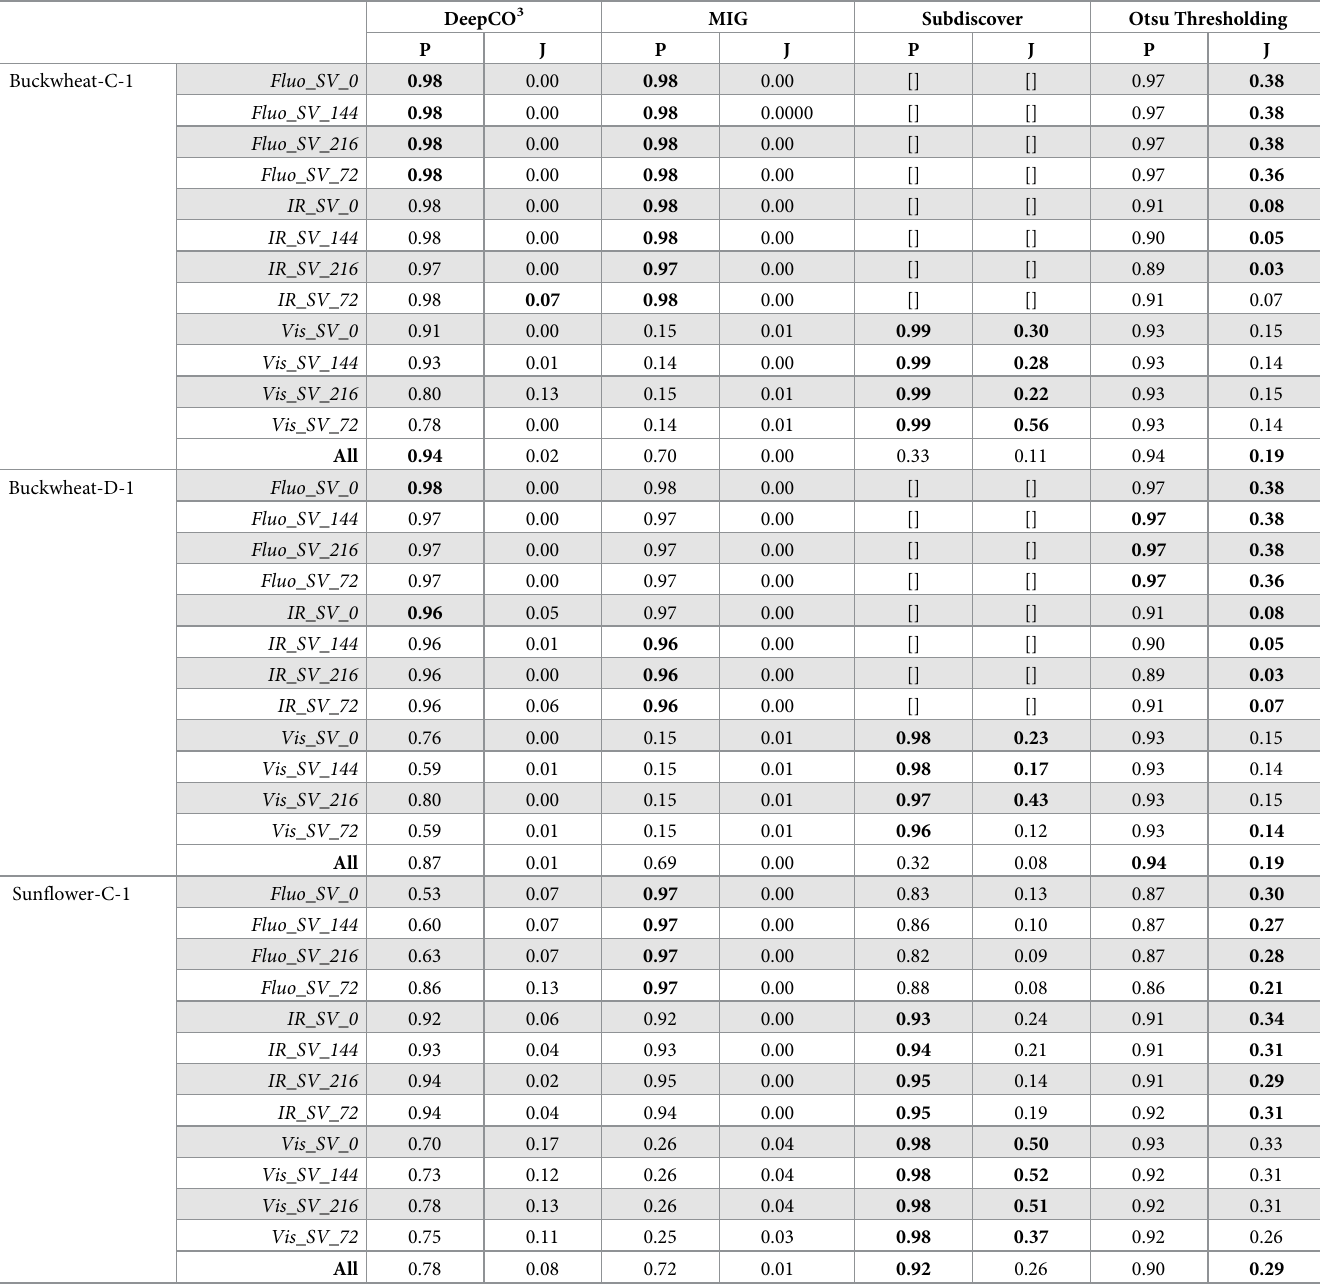
Table 6. Results of three cosegmentation methods and one segmentation method on CosegPP .